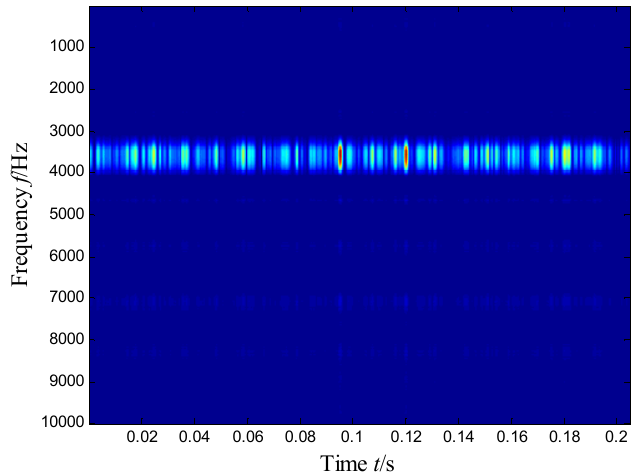
Figure 24. Selected time–frequency subspace for KNMF.